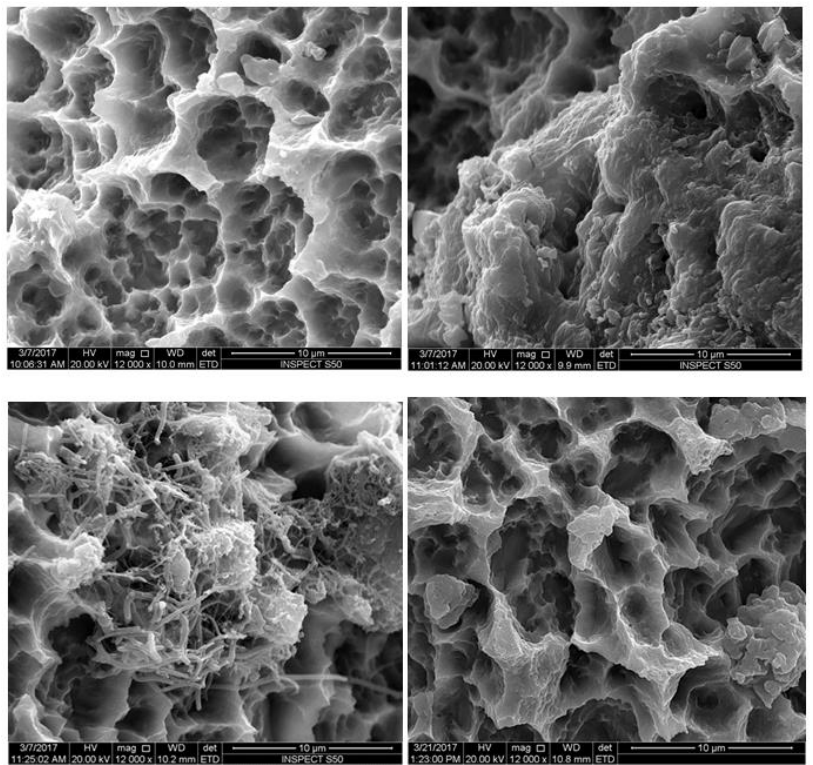
Table2. Colonyformingunits(CFU)forthetestedbacteriainrelationtothedifferentdecontaminationmethod. Study Groups Group I Er,Cr:YSGG (2790 nm)